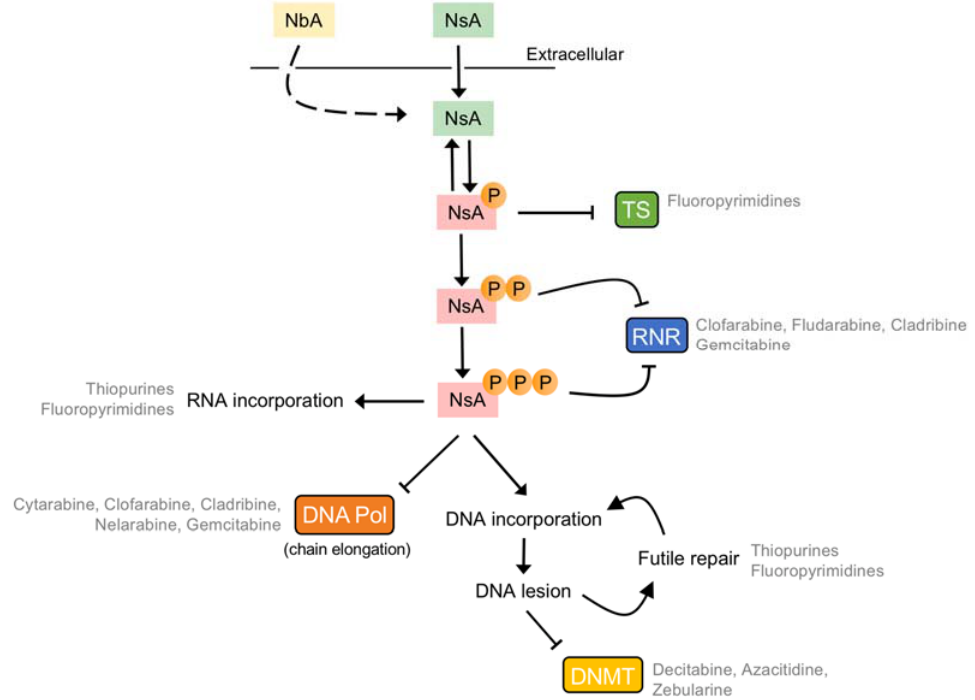
Figure 3. Overview on the pharmacodynamics of nucleobase/nucleoside analogues. Nucleobase (NbA, light yellow) and nucleoside analogues (NsA, light green) are metabolised intracellularly to produce their active metabolites (NsA, light red), be it the mono ‐ (P), di ‐ (PP) and triphosphate (PPP) species. These can inhibit key enzymes in DNA precursor metabolism, such as thymidylate synthase (TS) or ribonucleotide reductase (RNR), or be incorporated into nucleic acids. Here, these analogues can perturb DNA synthesis by DNA polymerases (DNA Pol) at the extension step, or the resultant genomic lesions can inhibit other enzymes, such as DNA methyltransferases (DNMTs), or lead to futile DNA repair cycles.